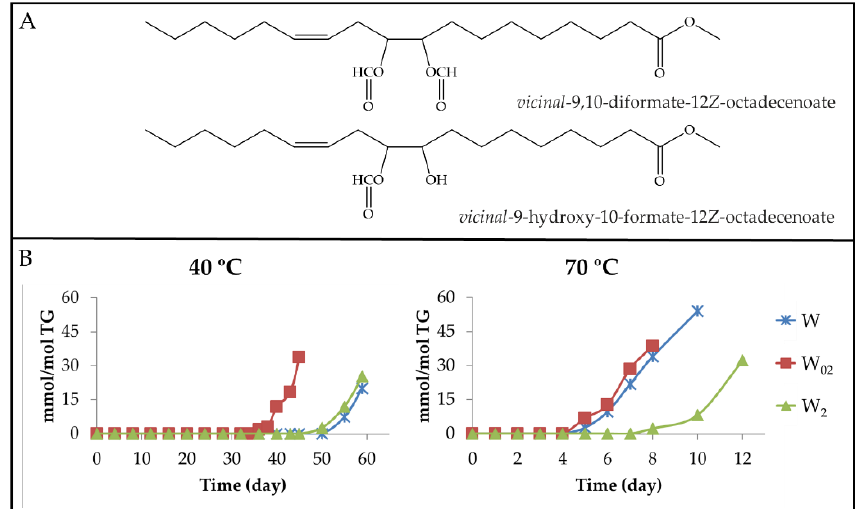
Figure 20. ( A ) Structure of an example of long-chain derivatives supporting vicinal dF and vicinal mF-mOH groups. ( B ) Evolution of the concentration expressed as mmol/mol TG, of total formate groups in walnut oil samples having different enrichment level in αT (W, W 02 and W 2 ), submitted to either 40 °C or 70 °C up to advanced stages of the oxidation process.